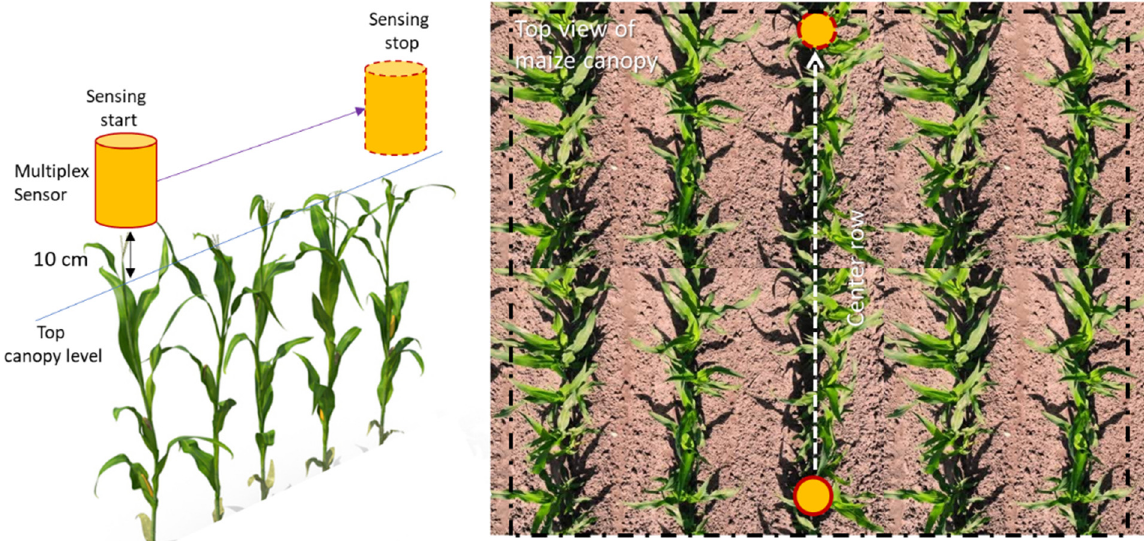
Figure 1. Schematic view of the mobile acquisition mode of Multiplex sensor over maize canopy. Canopy-based fluorescence measurements also consider non-vegetative objects (back- ground soil) and other noises. To compensate for non-vegetative and saturated signals, characteristics of the far-red fluorescence induced by red (FRF_R) was used. In general, the FRF_R generates two crests of voltage at 0–20 mV and above 100mV. Hence, a threshold at 20 mV was set, and the readings with values less than threshold at FRF_R were discarded from the data set. Additionally, a filtering was necessary for the fluorescence